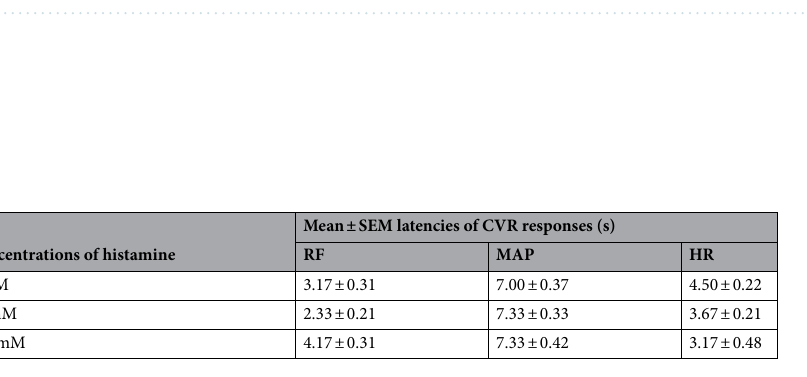
Figure 5. Time-response relationship of 10 mM histamine on mean arterial pressure (MAP), respiratory frequency (RF) and respiratory minute volume (RMV), after ipsilateral sciatic and femoral nerve sectioning (+NX), bilateral vagotomy (+VagX) and pre-treatment with lignocaine (+Ligno). The responses of histamine (10 mM) only group are given in the left panel of each row along with neurotomized group. The values are in mean ± SEM from 6 experiments in each group. (*) indicates P < 0.05, two sided Dunnett’s test as compared with the histamine (10 mM) only group; (#) indicates P < 0.05, Unpaired t-test as compared with the histamine (10 mM) only group. Arrows indicate the point of injection of histamine. HR responses are not included in this figure as 10 mM histamine did not produced significant HR alterations as compared to the control group [Fig. 3].